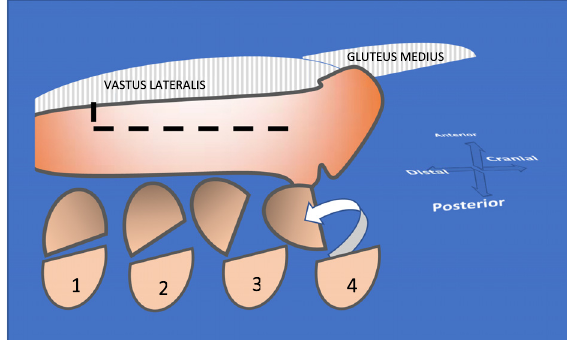
Figure 2. Original Wagner ’ s